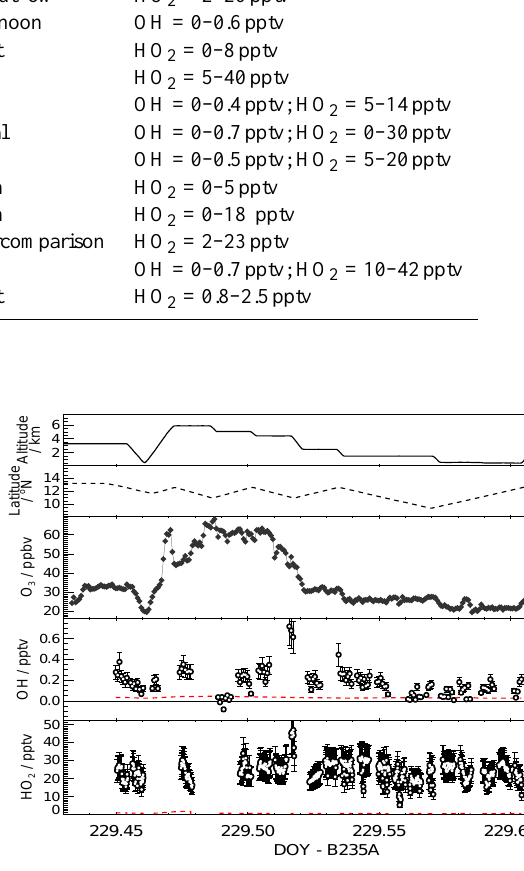
Fig. 9. Time Series of an afternoon flight from 10:40 to 15:00UTC over the forest region in the north of Benin showing (a) alti- tude (km), (b) latitude ( ◦ N), (c) O 3 (ppbv), (d) OH (pptv, 60s reso- lution) and limit of detection (pptv, red dashed line, 60s resolution) and (e) HO 2 (pptv, 10s resolution) and limit of detection (pptv, red dashed line, 10s resolution). Error bars on OH and HO 2 indicate the instrumental